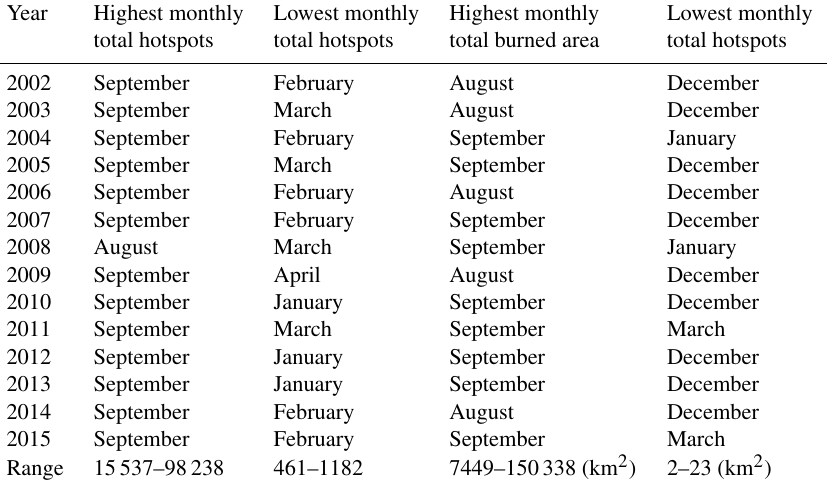
Table 1. Estimate of the month presenting highest monthly total hotspots, lowest monthly total hotspots, highest monthly total burned area and lowest monthly total hotspots and range of the values found in the Cerrado biome for the 2002–2015 time series. Year Highest monthly Lowest monthly Highest